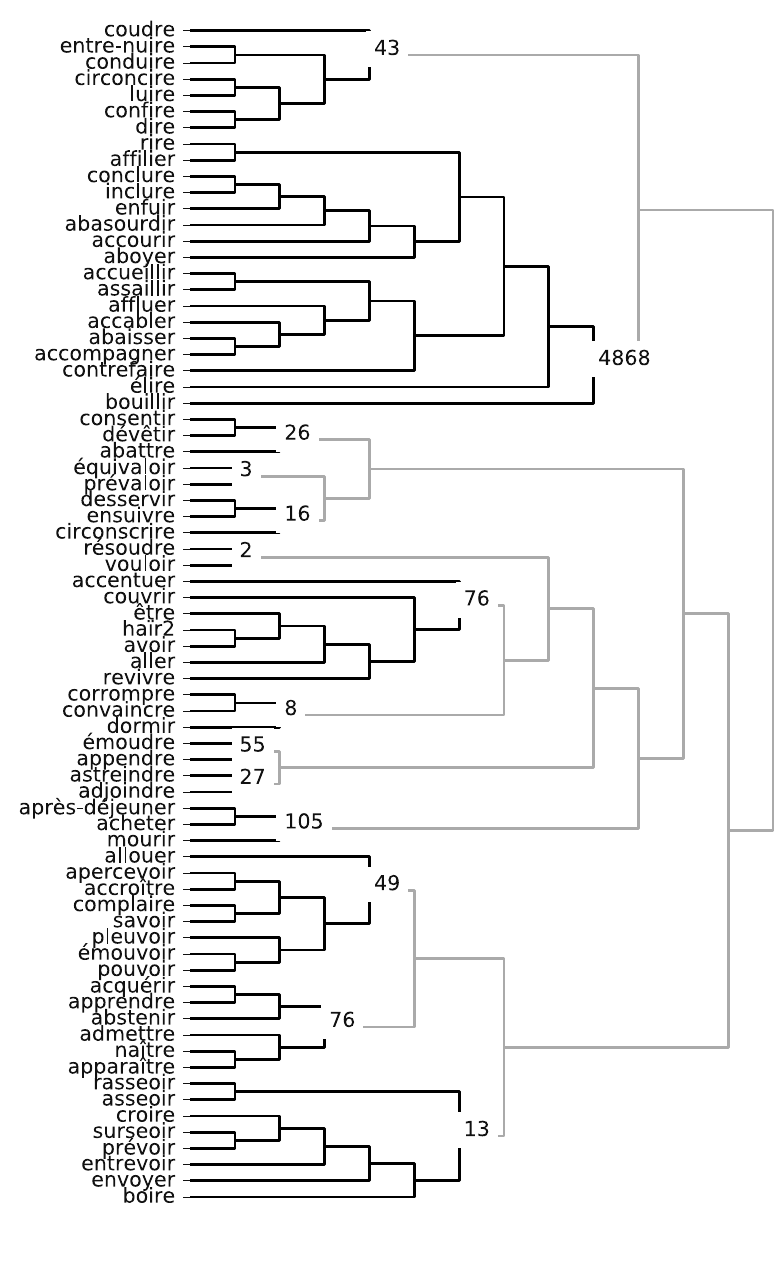
Figure 6: History of merges for European Portuguese macroclasses, on global